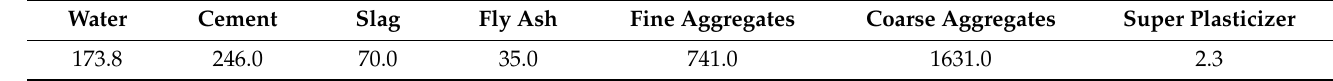
Figure 1. The schematic diagram of the electrolytic tank and concrete disc ( a ) and an experimental photo of the assembled testing devices ( b ). Table 2. The mixture proportions of concrete (kg/m 3 ).